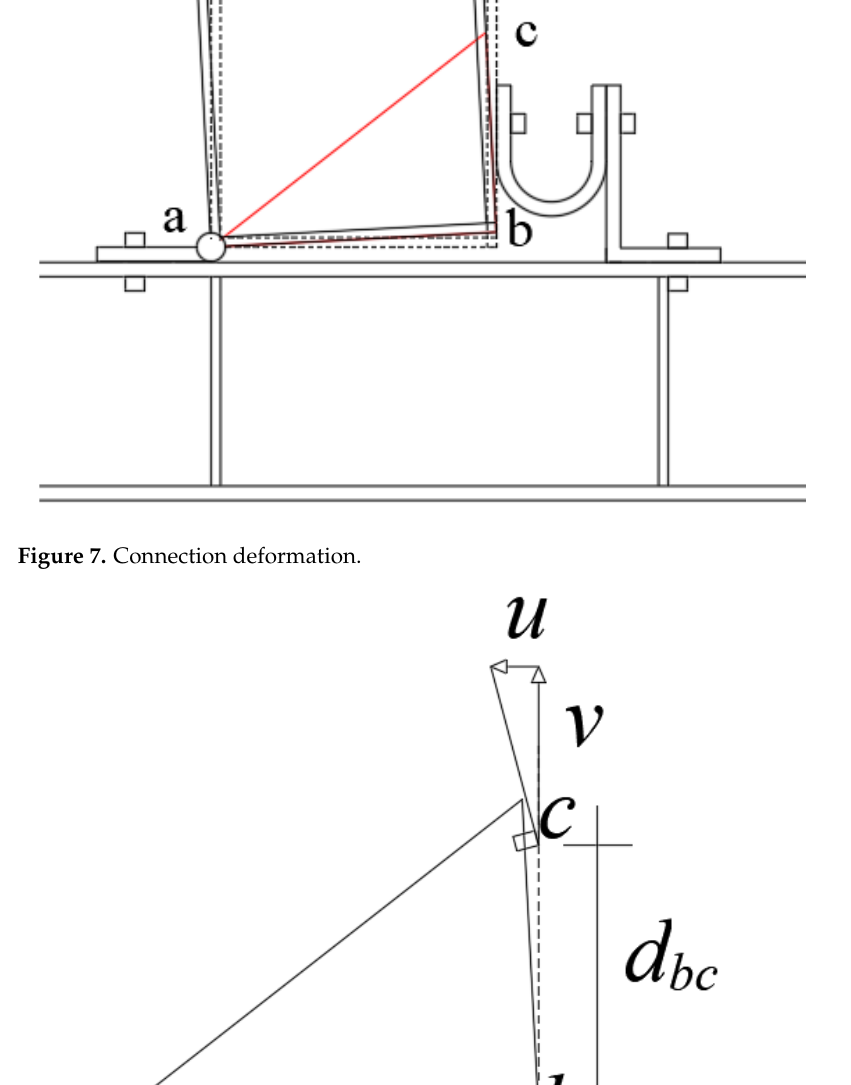
Figure 7. Connection deformation.